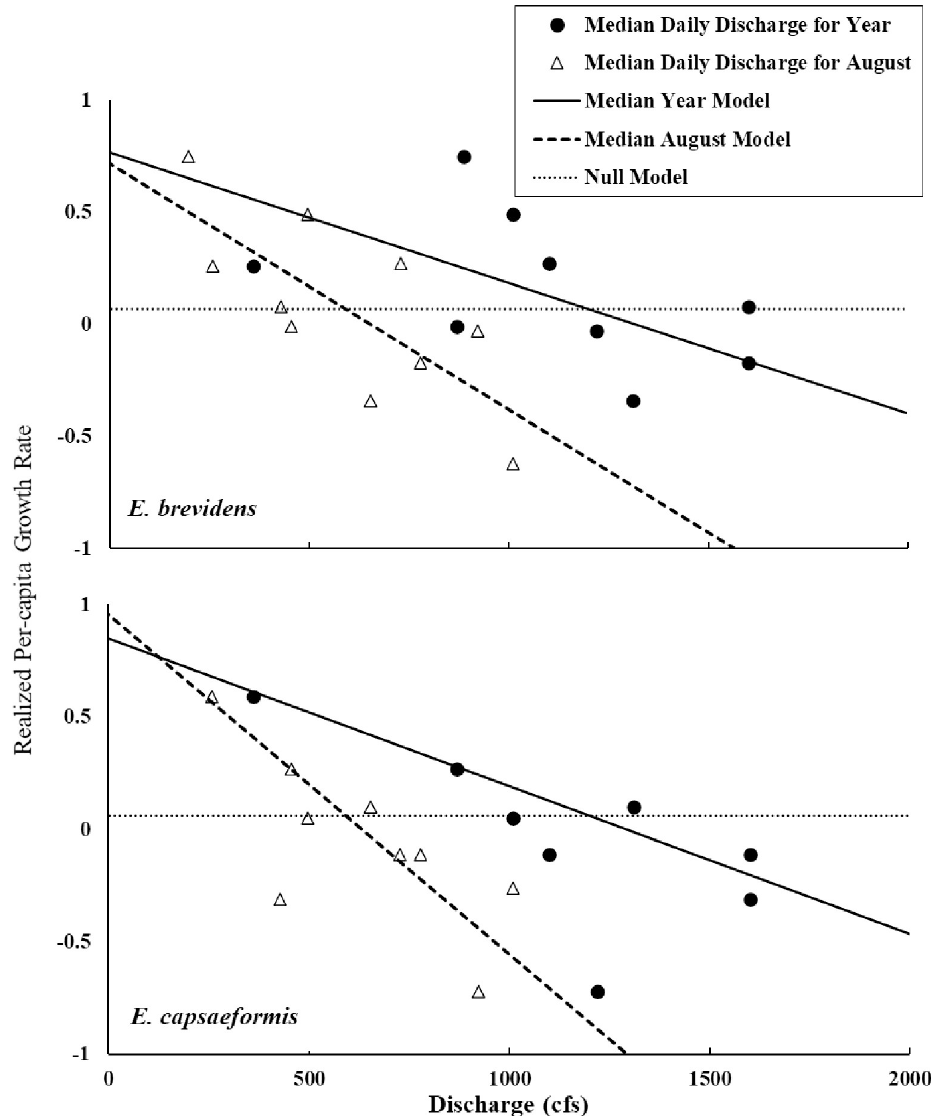
Fig 12. Median daily discharge for each year and for August were negatively associated with realized per-capita growth rate for Epioblasma brevidens (top) and E . capsaeformis (bottom). Growth rate was calculated using both juveniles and adults